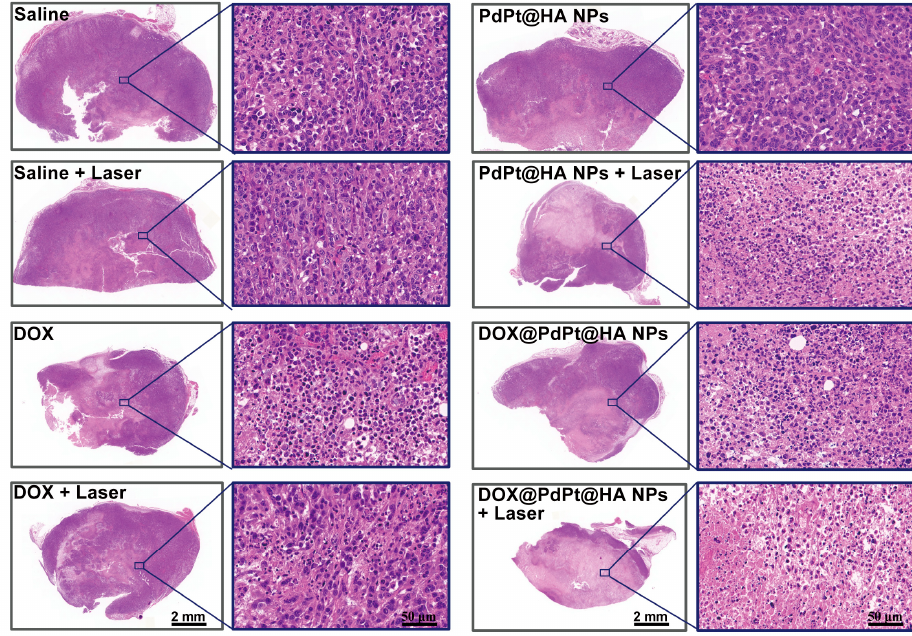
Figure 5. Representative hematoxylin-eosin (H&E) staining images of tumors from animals in different groups. The square in the whole-slide scanned images delineates the magnified subfield on the right.